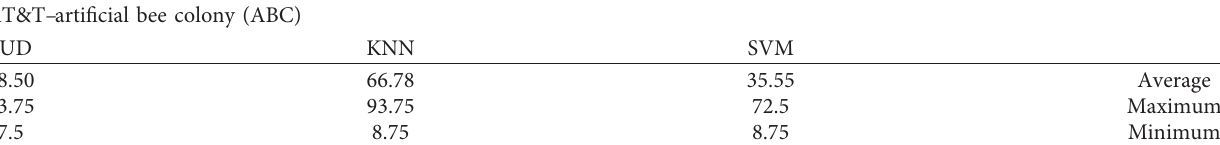
Table 7: Recognition accuracies for the AT&T database with the PSO